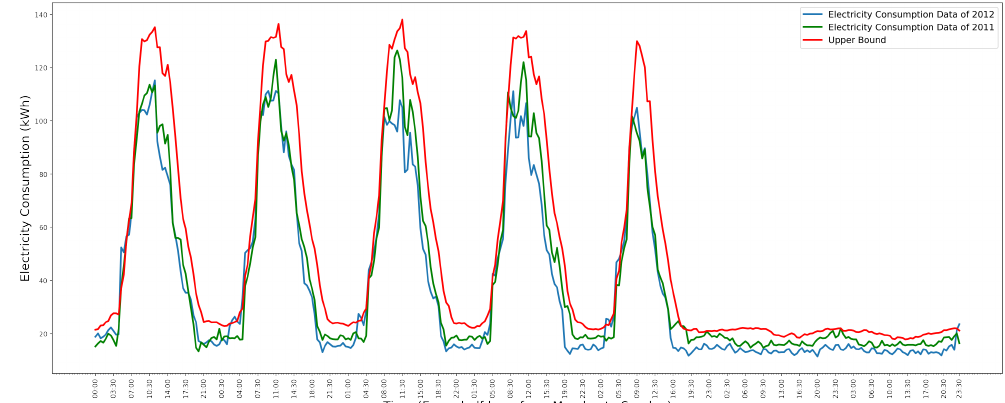
Figure 12. Anomaly detection on normal weekly data based on Gaussian distribution model. Adapted from